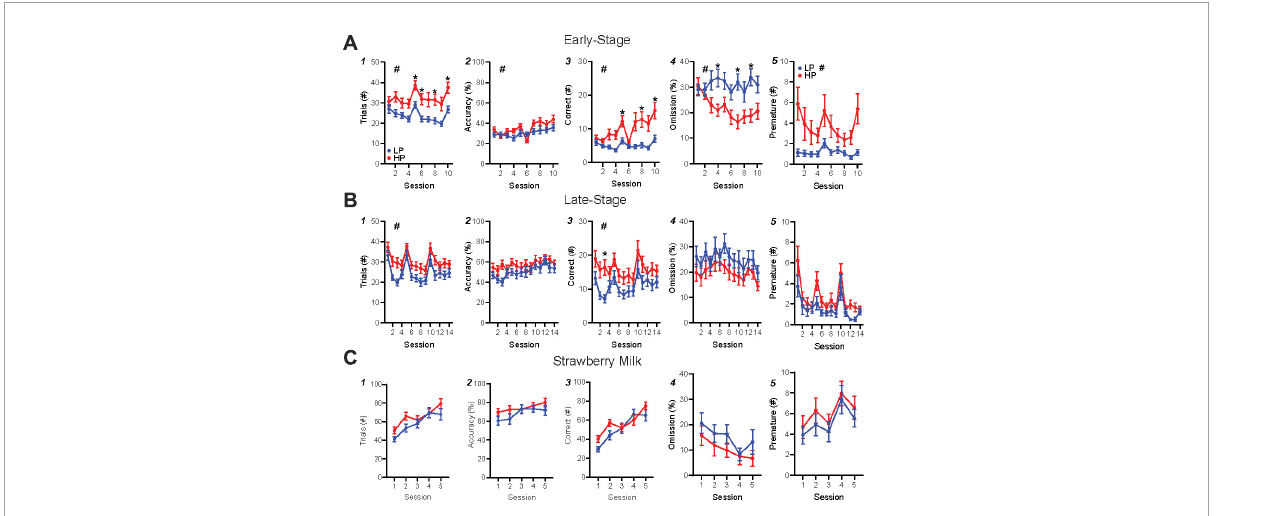
FIGURE2 HP versus LP early-stage and late-stage alcohol, and SM training in the 5-CSRTT. (A) Early-stage performance showed differences in trials, accuracy, correct ( post hoc significance on session 3), % omission, and premature between HP and LP mice. (B) Late-stage performance displayed HP-LP differences in trials and correct, but not accuracy, % omission or premature. (C) SM performance showed no differences in any metric. n = 24/group for preference. # p < 0.05 for group effect. * p < 0.05 post hoc significance. All data are expressed as ± standard error